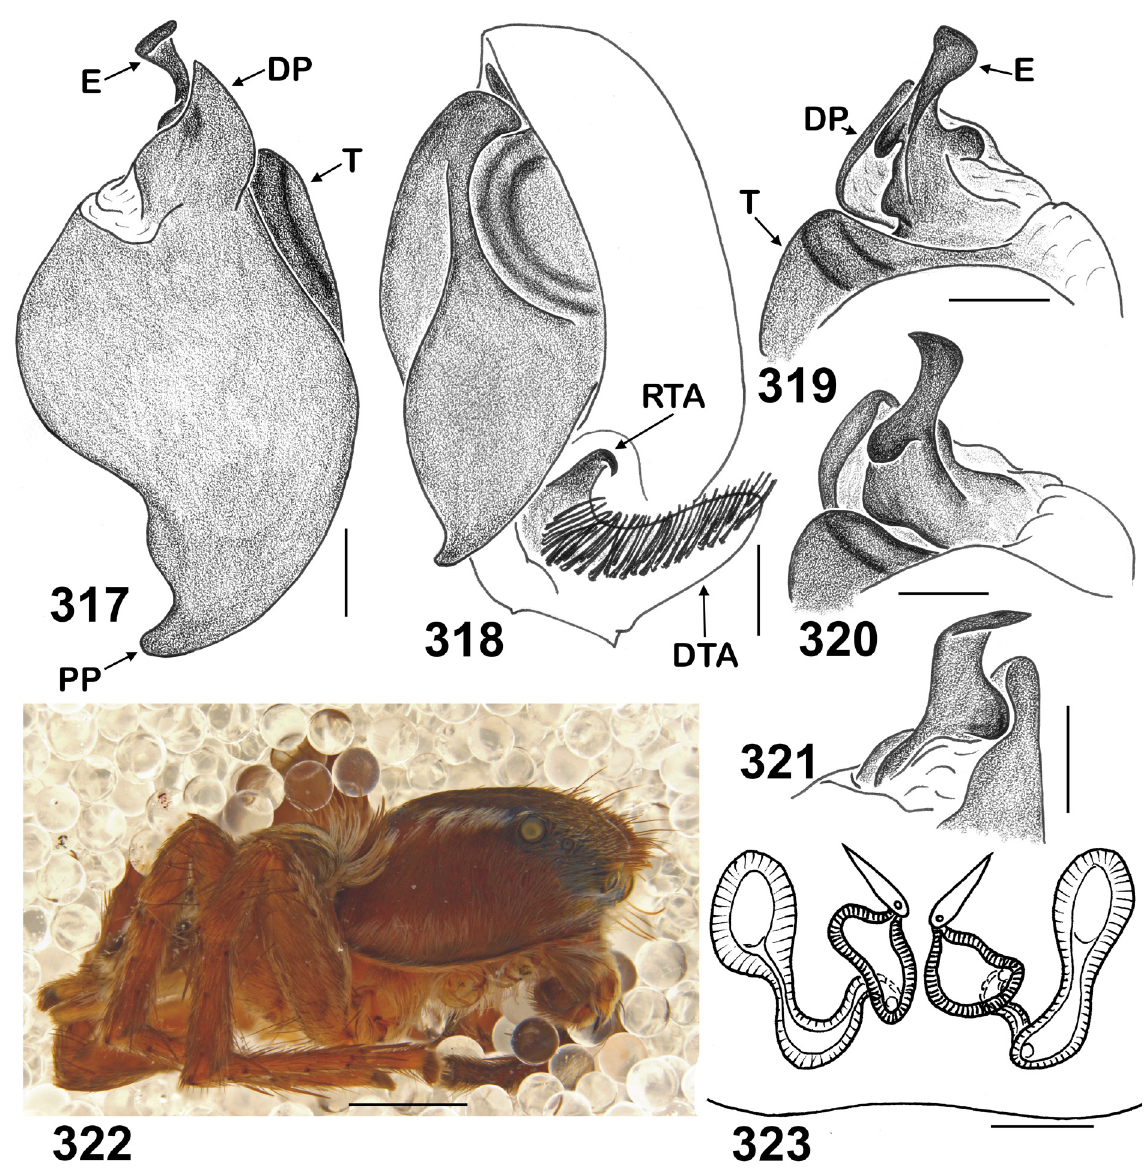
Figs 317–323. Stenaelurillus kronestedti Próchniewicz & Heçiak, 1994, holotype, ♂ (317–322) and paratype ♀ (323) . 317 . Bulbus, ventral view. 318 . Male palp, retrolateral view. 319 . Embolic division, dorsal view. 320 . Embolic division, retrolateral view. 321 . Embolic division, median view. 322 . General appearance. 323 . Spermathecae, dorsal view. Abbreviations: see Material and methods. Scale bars: 317– 321, 323 = 0.1 mm; 322 = 1